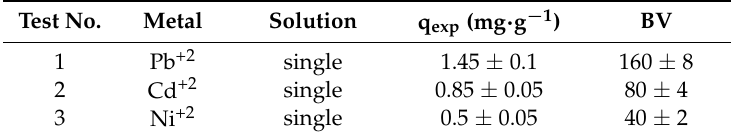
Figure 3. Breakthrough curves in distilled water for single ion solutions of lead, cadmium, and nickel Table 2. Sorption parameters for single ion solutions of lead, cadmium, and nickel ions (0.2 Lh − 1 flow rate, 2 mg Me +2 L − 1 , 10 g RWPG, 0.5–1 mm bead size range, and T = 298